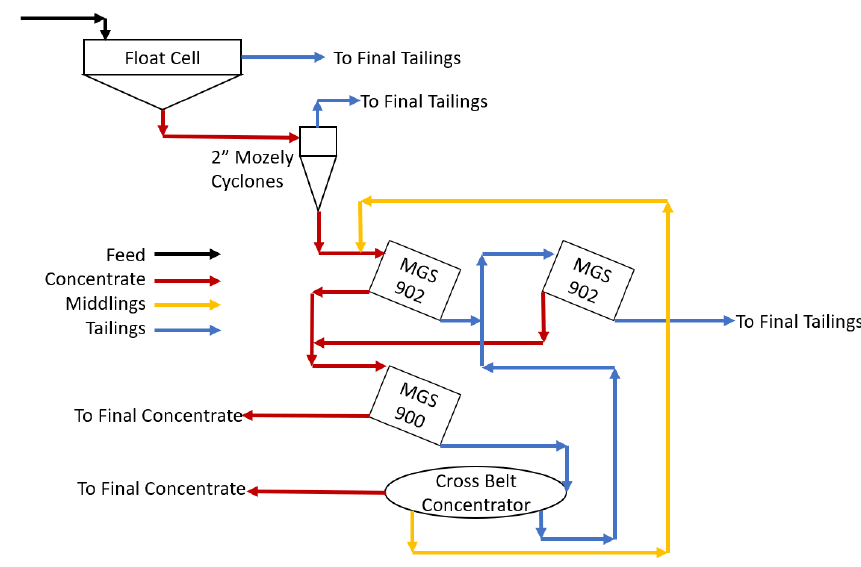
Figure 1. Original TANCO tantalum gravity circuit, recreated for legibility [3].